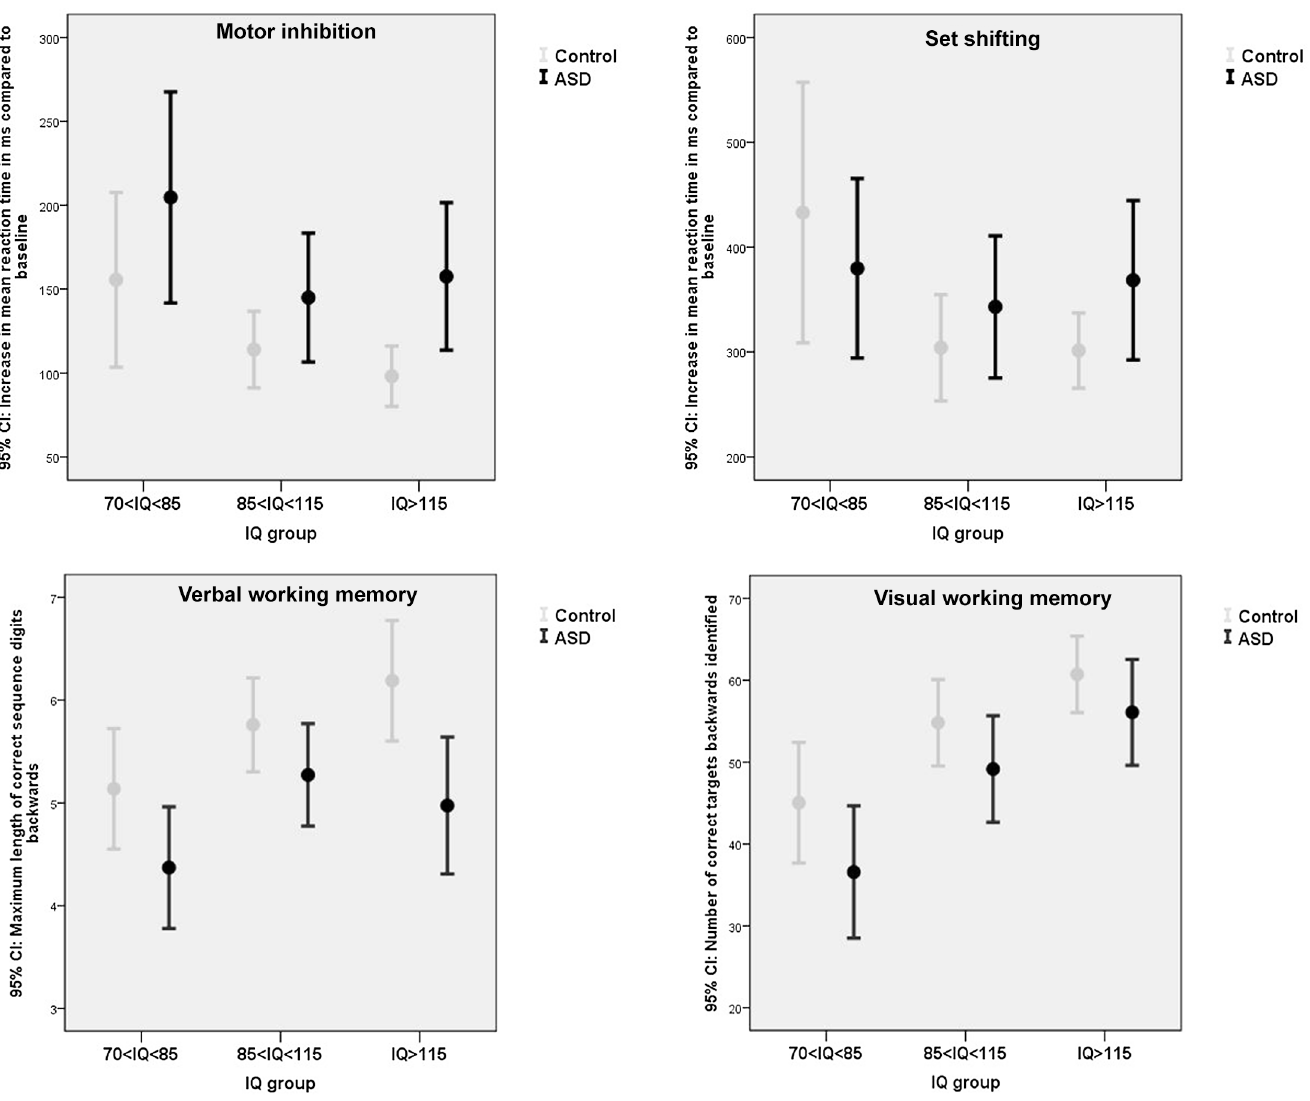
Fig 3. The effect of ASD and IQ on executive functioning (motor inhibition, set shifting, verbal working memory, visual working memory). Measures of speed are depicted for inhibition and set shifting. Please see S2 Fig for measures of